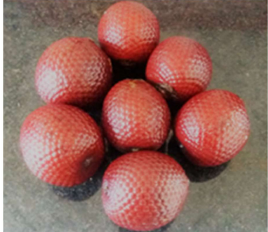
Figure 1. Buriti ( Mauritia flexuosa )